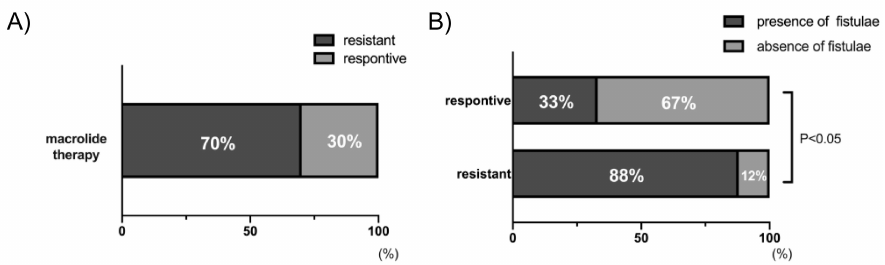
Figure 3. Outcome and prognostic factors after macrolide therapy in patients with OMS. ( A ) Outcome after macrolide therapy; ( B ) outcome by the presence or absence of oroantral fistulae. p < 0.05. Fisher’s exact